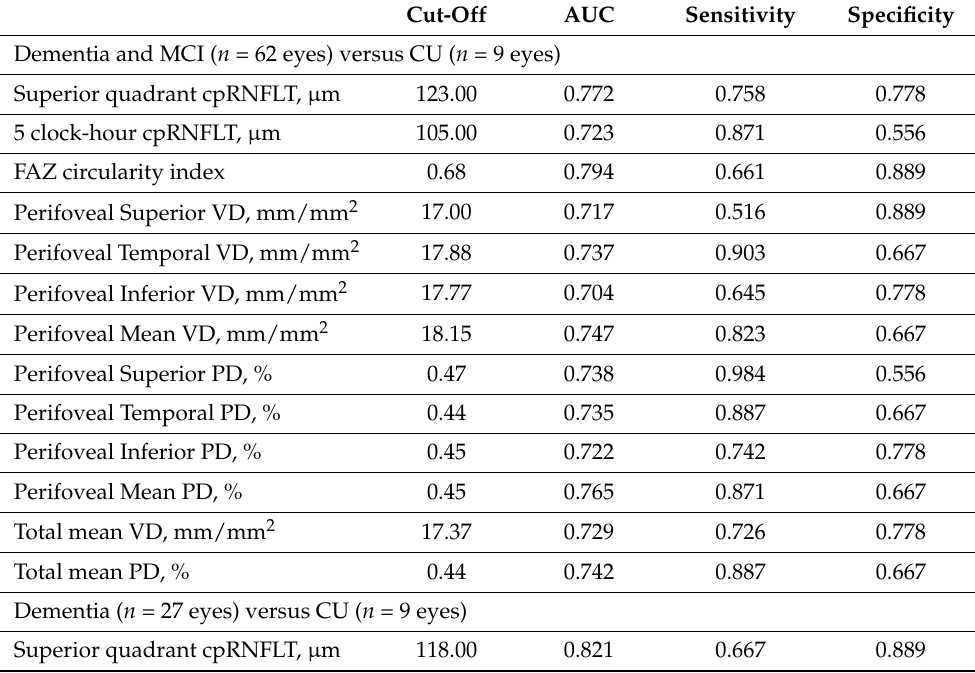
Table 3. Diagnostic performance of OCT and OCTA parameters discriminating patients with demen- tia and/or MCI from CU